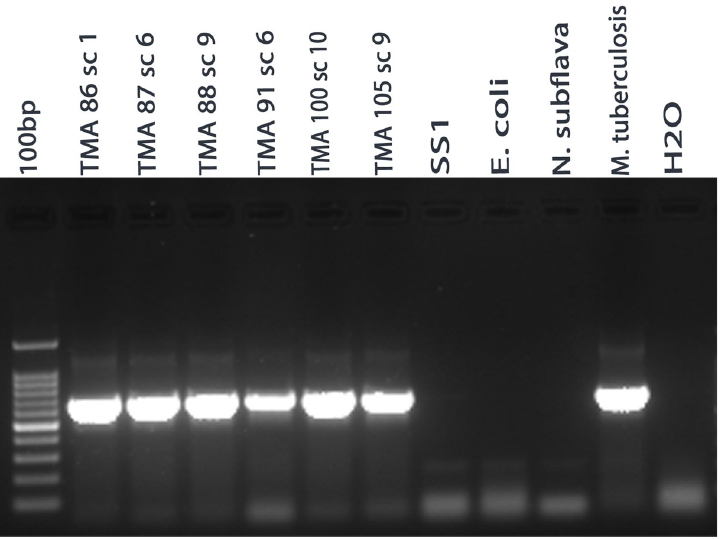
Fig 4. hsp65 gene PCR analysis to confirm that the isolated strains belong to Mycobacterium genus. TMA 86 sc 1, TMA 87 sc 6, TMA 88 sc 9, TMA 91 sc 6 TMA 100 sc 10 and TMA 105 sc 9 showed the amplification for hsp65 gene but H . pylori , E . coli DH5a and N . subflava gave no amplicon. DNA isolated from M . tuberculosis was used as positive